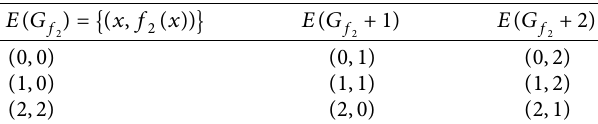
Table 5: Te graph G f 2 and it’s translates for Example 4.